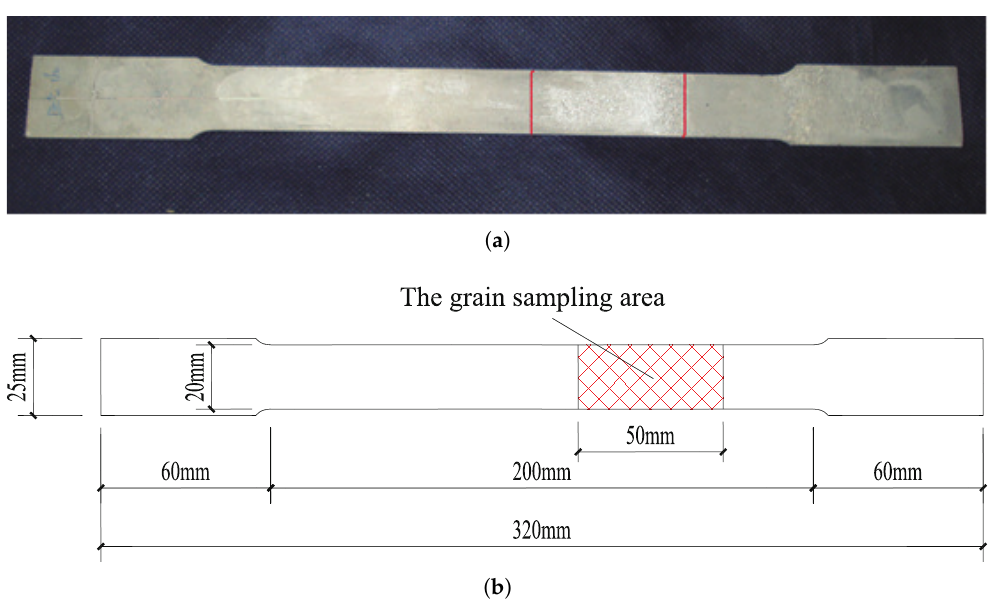
Figure 2. ( a ) The original grain on pure aluminum plate specimen (natural speckle); ( b ) the dimen- sions of the plate